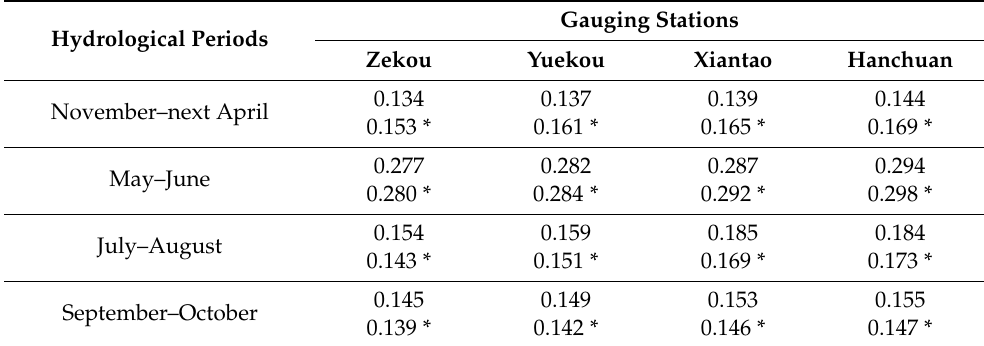
Table 3. Hysteretic relationships between the river flow and the stage at the gauging stations. Hydrological